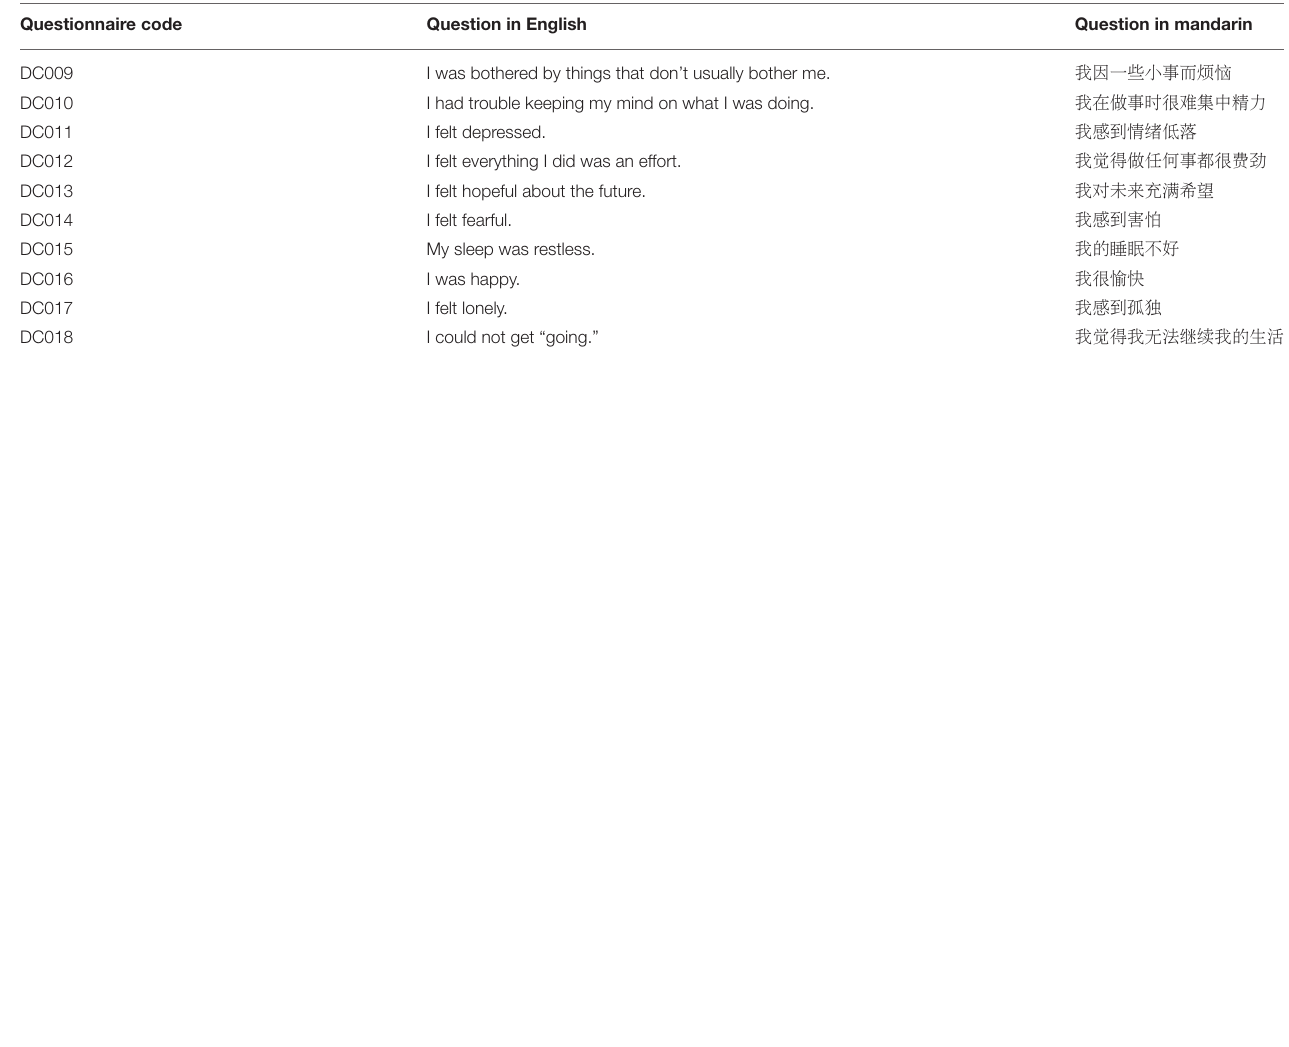
Table A1 | CES-D questions (in English and